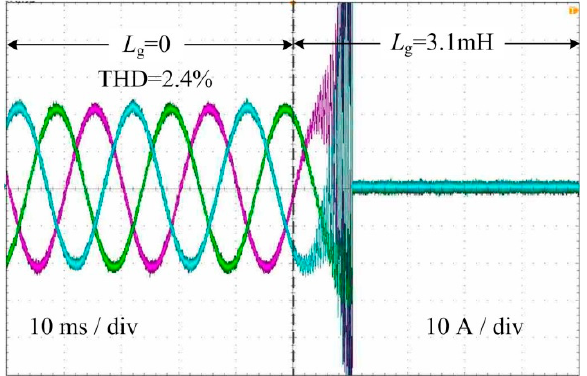
Figure 17. Output currents of the conventional inverter with zero and nonzero grid impedance.